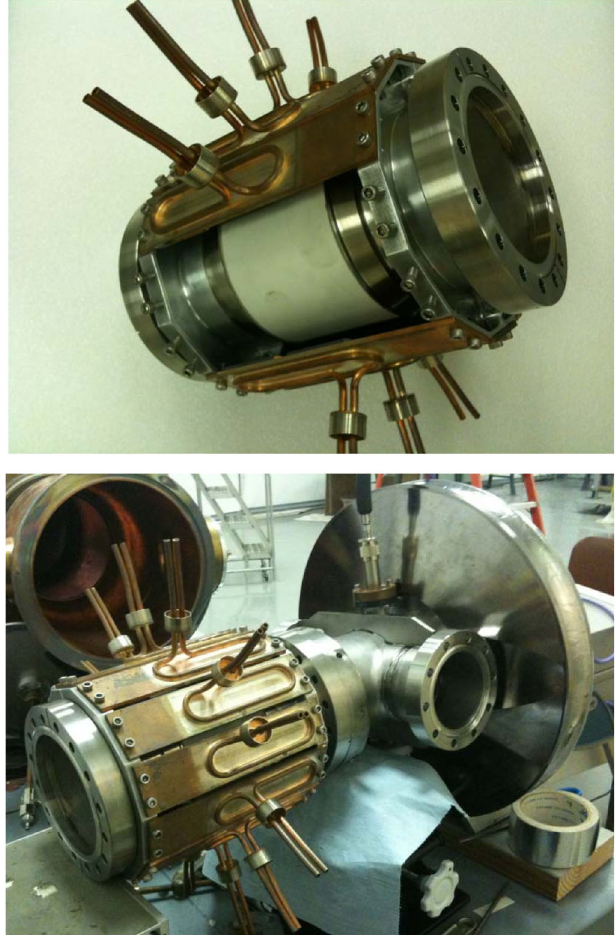
FIG. 29. The ceramic-ferrite damper with some ferrite tiles removed (top) and the SRF gun with the ceramic-ferrite damper assembled